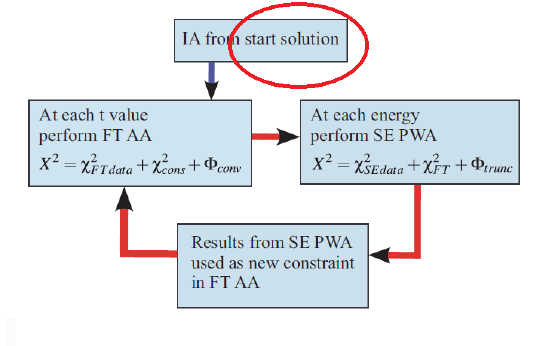
Figure 4: Iterative scheme for the fixed-t minimization. Circle designates the only step of the process which de- pends on some theoretical assumptions as ETA-MAID15a theoretical parameters are taken as start values for the first minimization. Figure is taken over from ref.